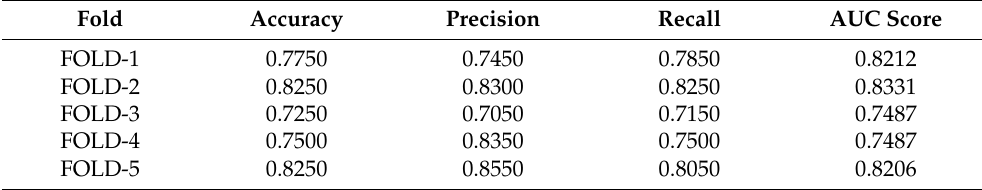
Table 8. The 5-fold cross validation results of the ICIAR2018 dataset.